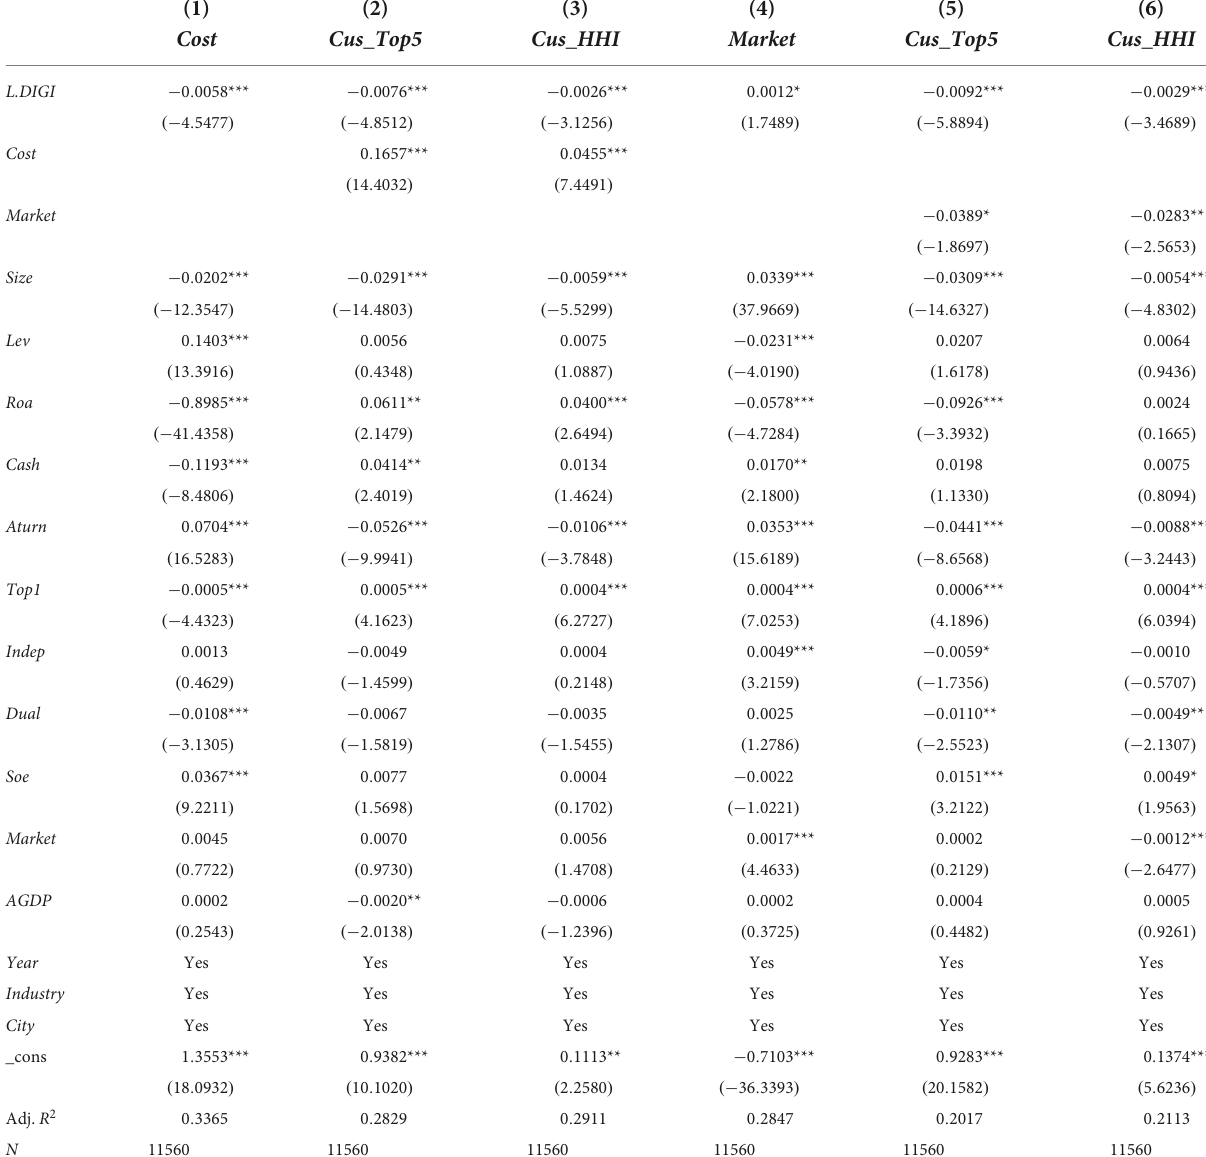
TABLE 9 Test results of mediating effects of operating costs and customer